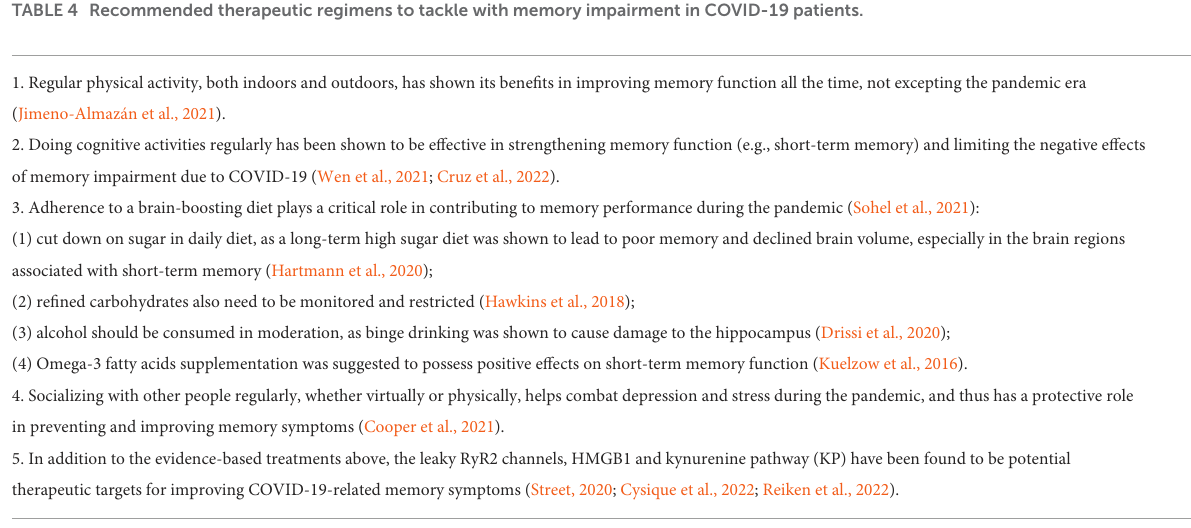
TABLE 4 Recommended therapeutic regimens to tackle with memory impairment in COVID-19